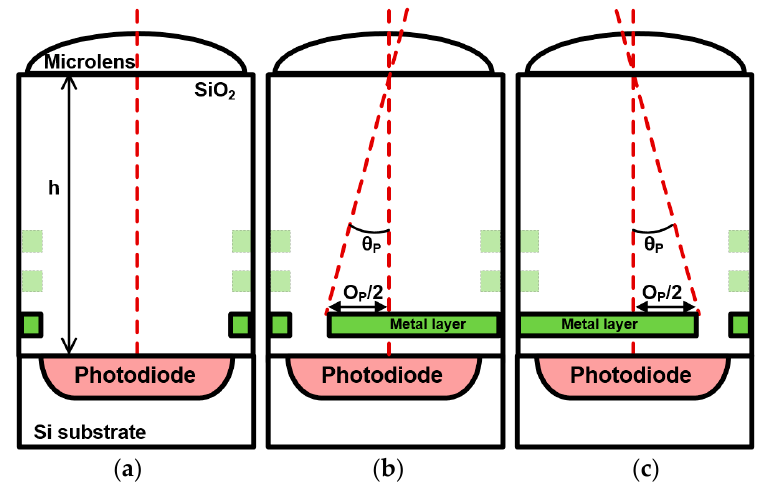
Figure 4. Vertical structures of ( a ) blue, red, green, ( b ) LOPA, and ( c ) ROPA pixels.